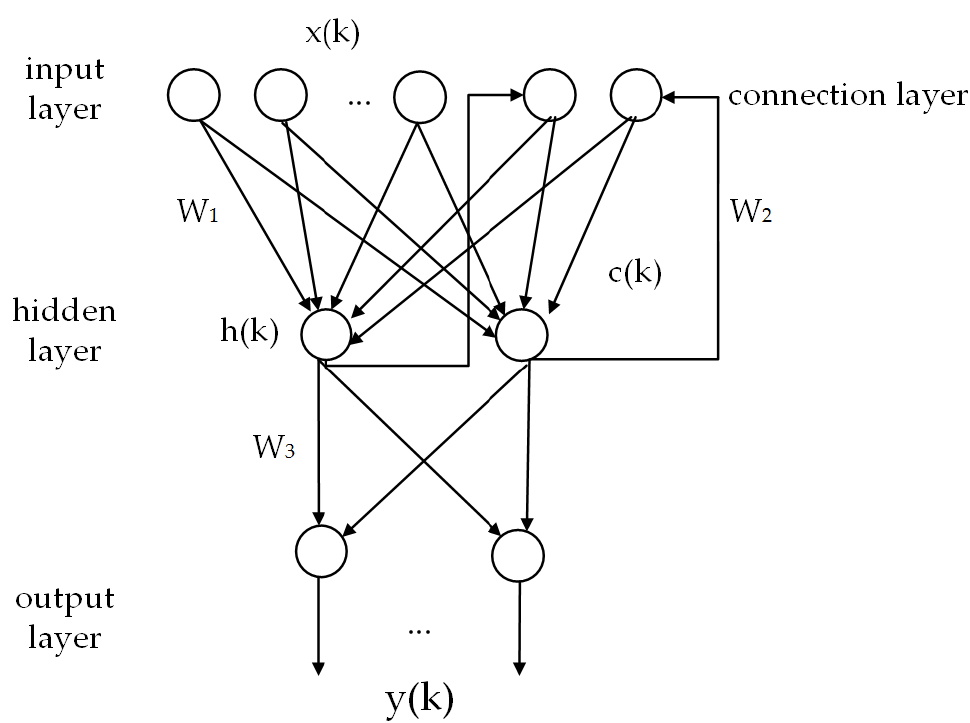
Figure 3. The composition of Elman neural network.